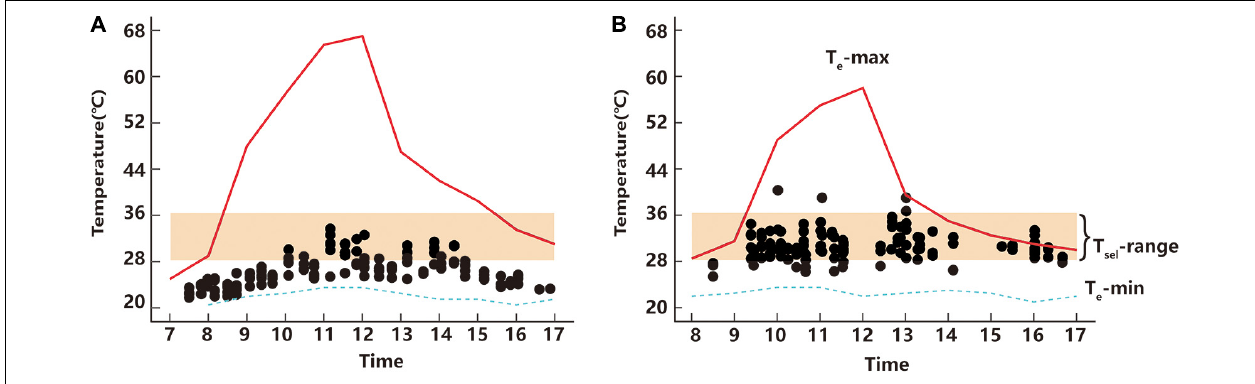
FIGURE 2 | Active body temperatures of T. kuehnei of April (A) and June (B) , respectively. The black spot represents the active body temperatures of each individual. The red solid and blue dash lines indicate the maximum and minimum operative temperatures, respectively. The orange shaded area represents the selected temperature